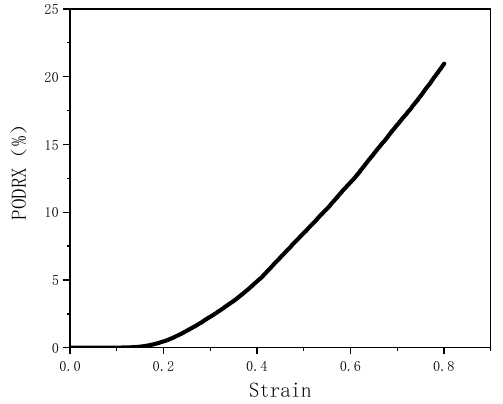
Figure 14. Relationship between PODRX and strain.